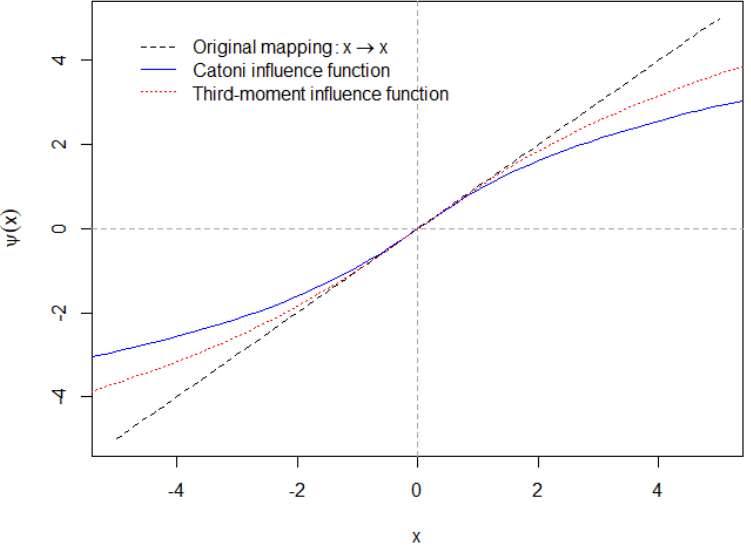
Figure 1. Different chooses of influence